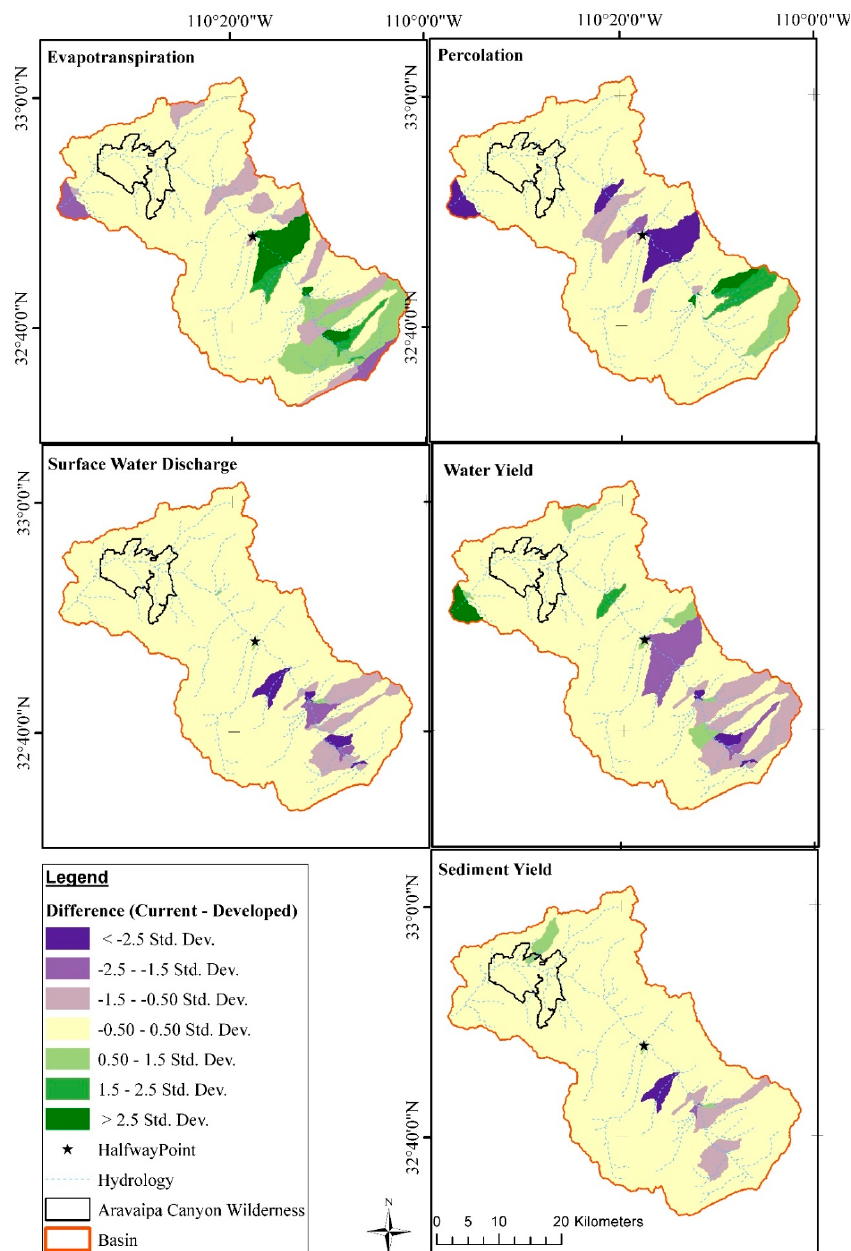
Figure 8. Difference in results between Current and Developed scenarios, from uncalibrated SWAT model iterations, where values above standard deviation (Std. Dev.; purple) show increased, and values below Std. Dev. (Green) depict decreases.